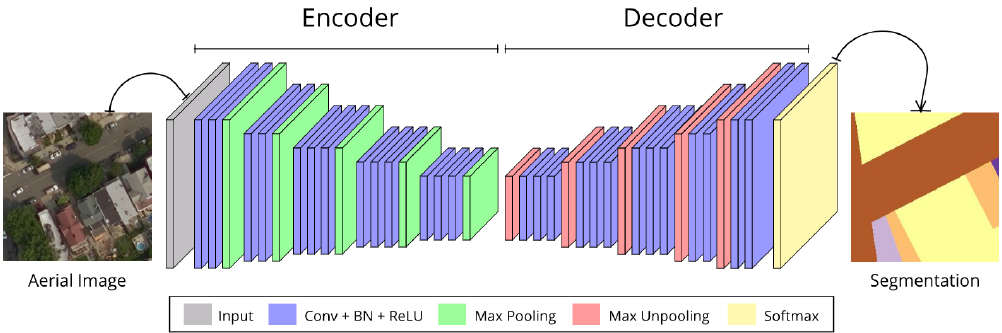
Figure 3. The network architecture of SegNet [42]. (Conv: convolution, BN: batch normalization, ReLU: rectified linear